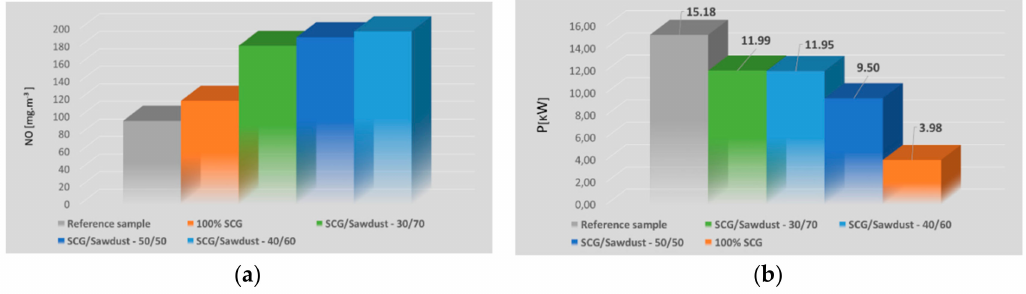
Figure 6. ( a ) Comparison of average NO emissions and ( b ) comparison of average heat power of the